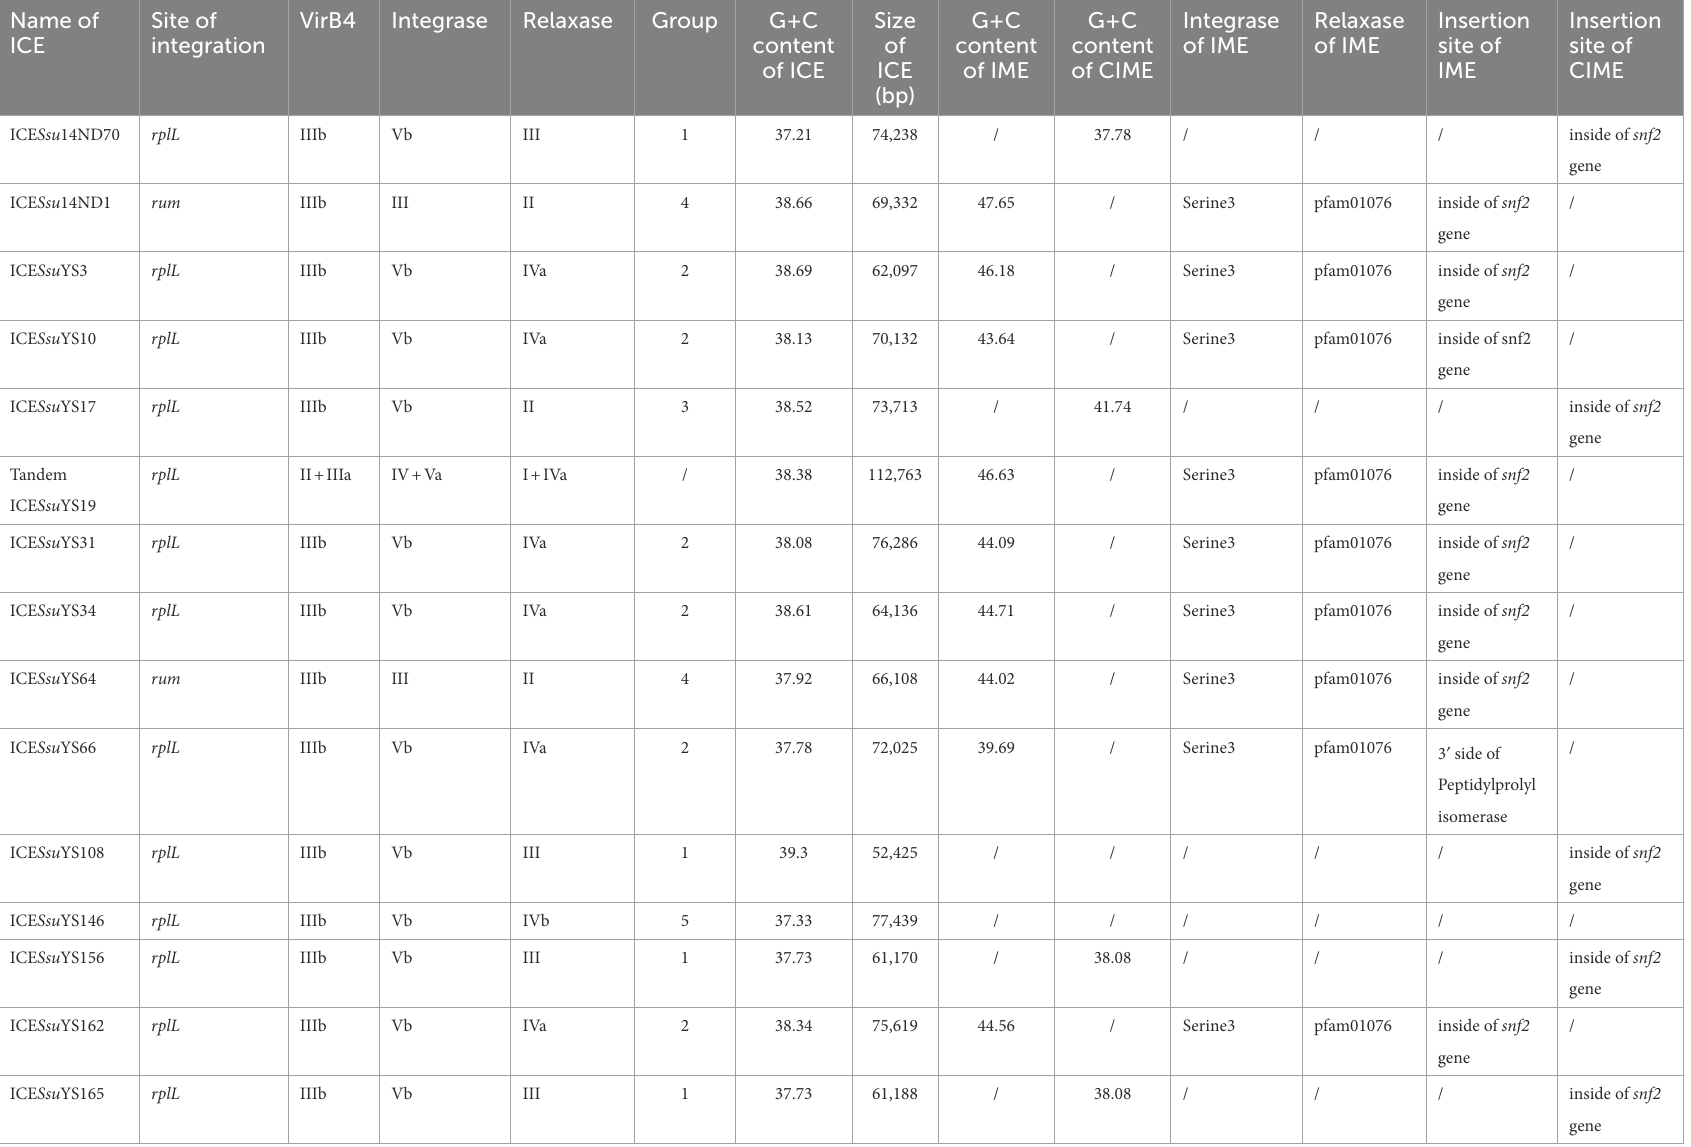
TABLE 1 Characteristics of ICEs, DICE and tandem ICE identified in the present